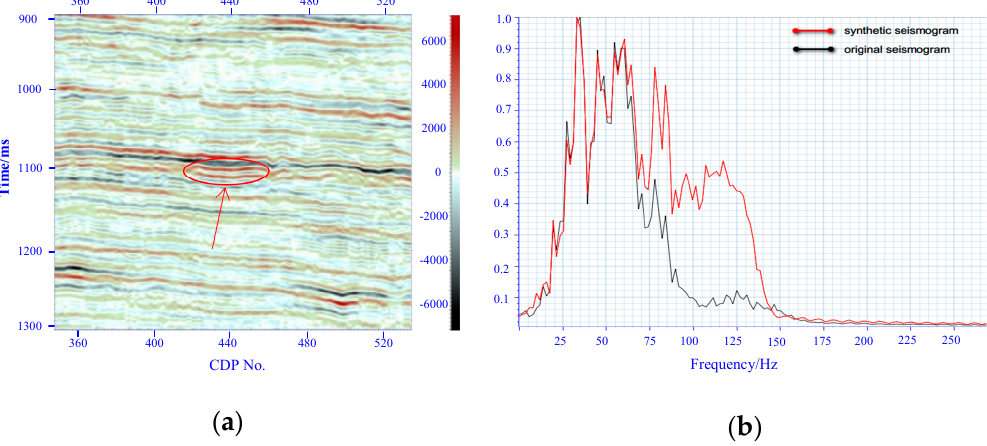
Figure 11. Reconstructed synthetic seismic section and its amplitude spectrum. ( a ) Reconstructed synthetic seismic section; and ( b ) amplitude spectrum of the reconstructed synthetic seismic section and the original field seismic section.